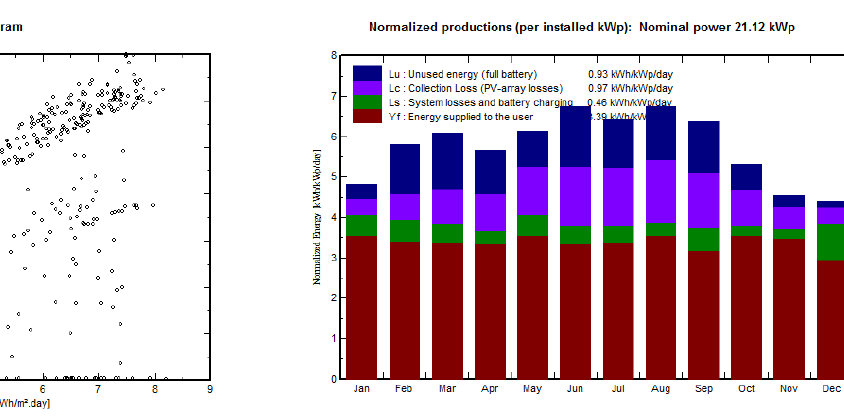
Table 10 Simulation results for the proposed PV system.